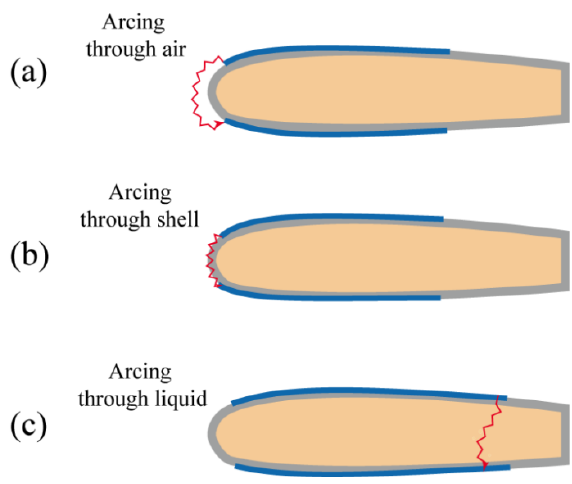
Figure 15. The potential arching paths through the air shell and dielectric liquid.